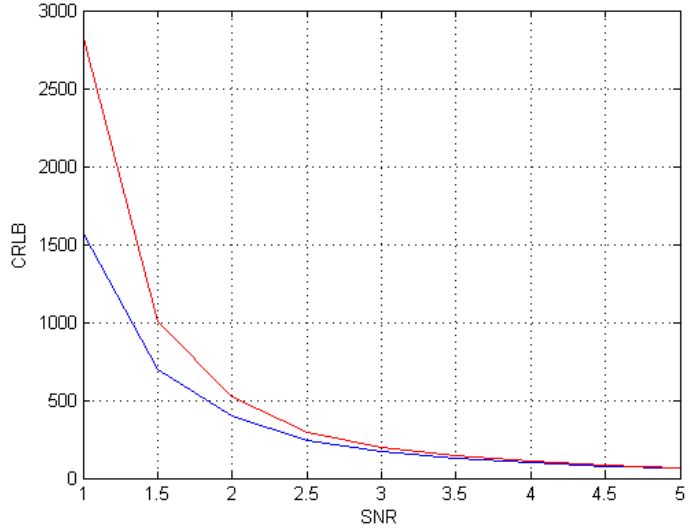
Figure 1. CRLB behavior in case of different SNRs for the proposed Gaussian Complex Model (blue) and for the Rice Amplitude Model (red).